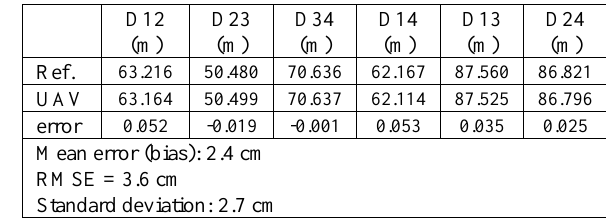
Table 2. Check distances (merged blocks)